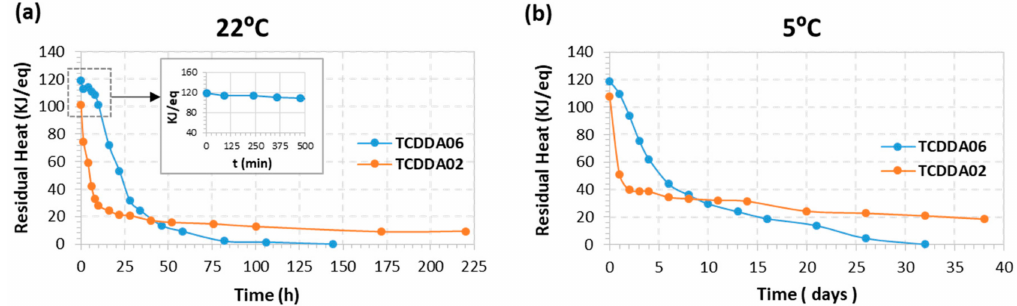
Figure 6. Results of latency evaluation at two di ff erent storage temperature for TCDDA02 and TCDDA06